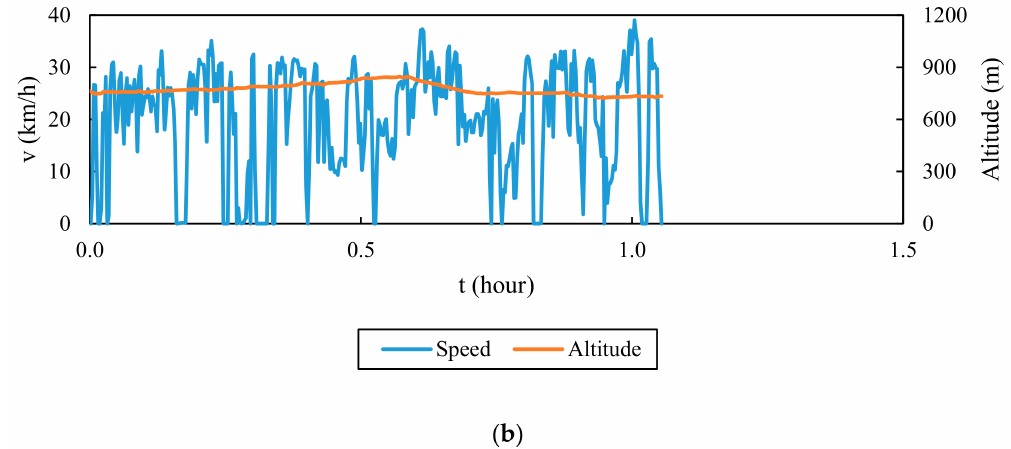
Figure 10. The speed and altitude data acquired from ( a ) the first route and ( b ) the second